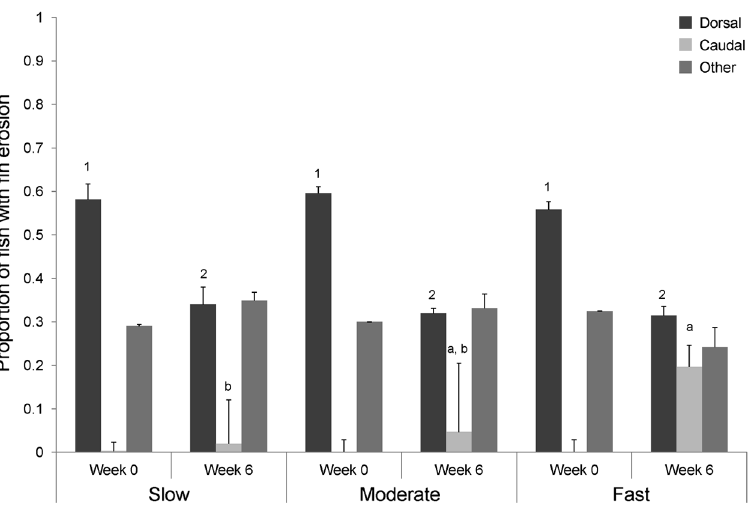
Fig. 5. Mean proportion of fin erosions separated into dorsal, caudal or other, with other including pectoral, pelvic and anal fins. Columns are presented for fish kept at slow (0.2 body length [BL] s −1 ), moderate (0.8 BL s −1 ) and fast (1.5 BL s −1 ) water current velocities at the start and end of a 6 wk experi- ment. Error bars represent SE. Lowercase letters denote significant differ- ences between water current velocities, and numbers denote significant differences between weeks (p <